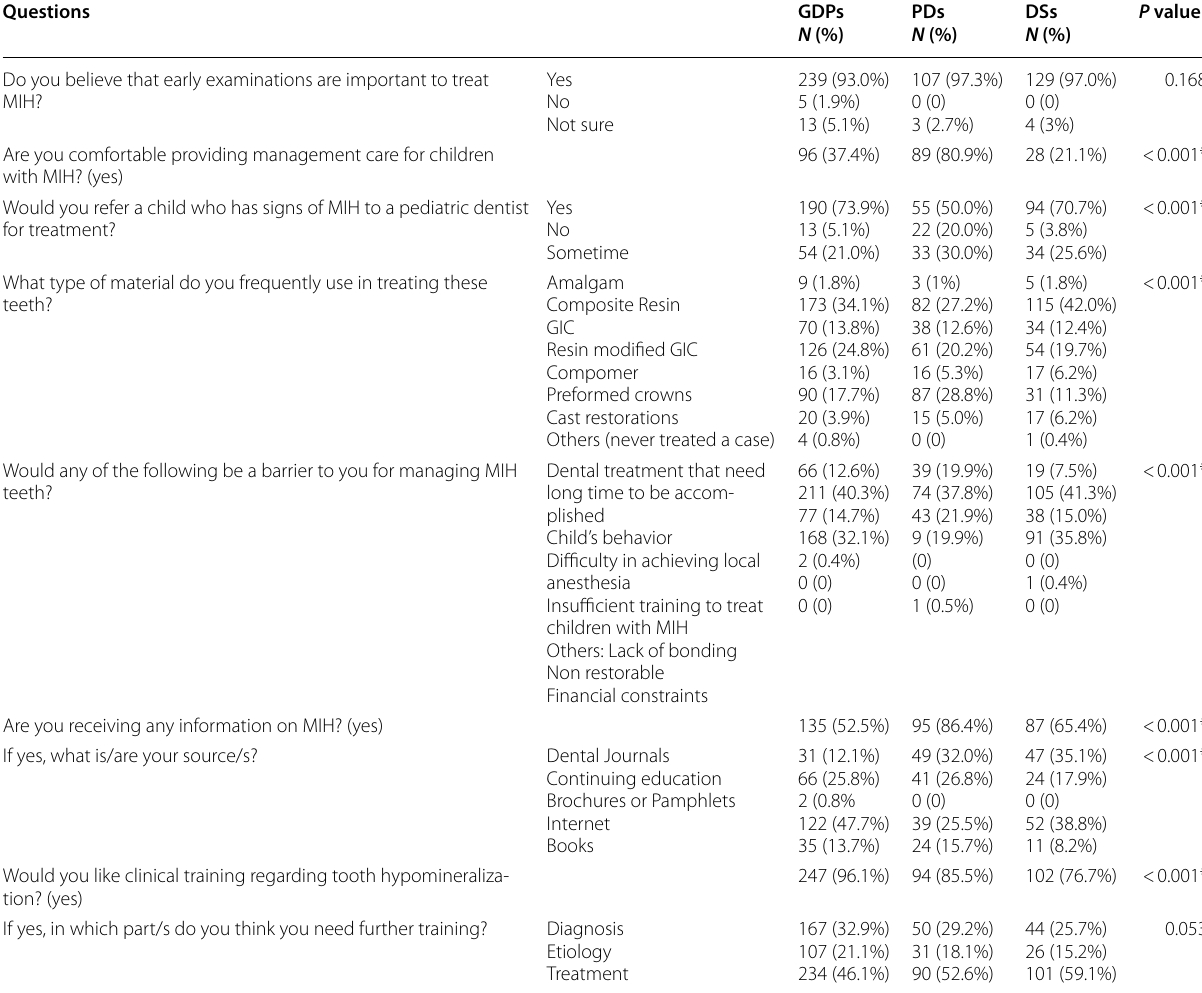
Table 3 Management considerations and continuing education